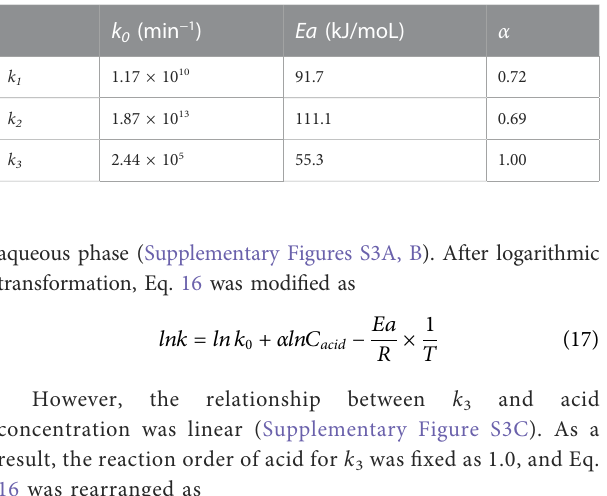
TABLE 2 Pre-exponential factor, apparent activation energy, and the reaction order of acid for the developed kinetic